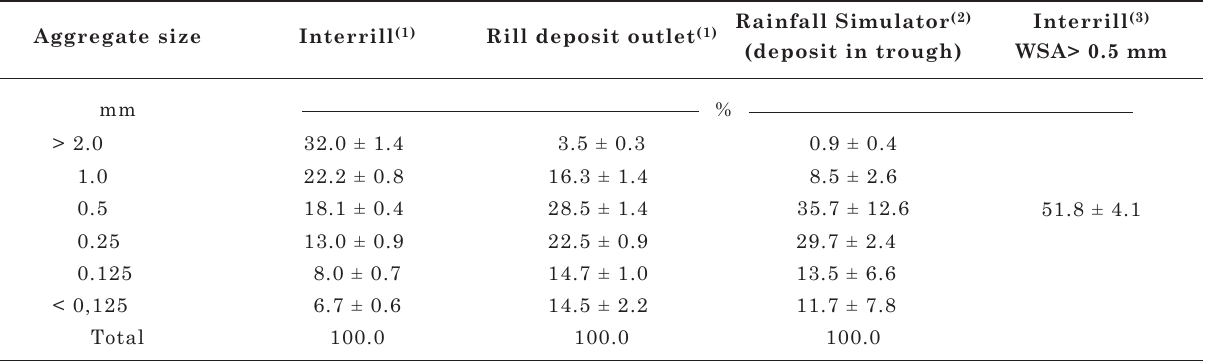
table 5. distribution of aggregate fraction according to different sieving conditions (dry or moist) and rill system positions (interrill, rill deposit and trough)